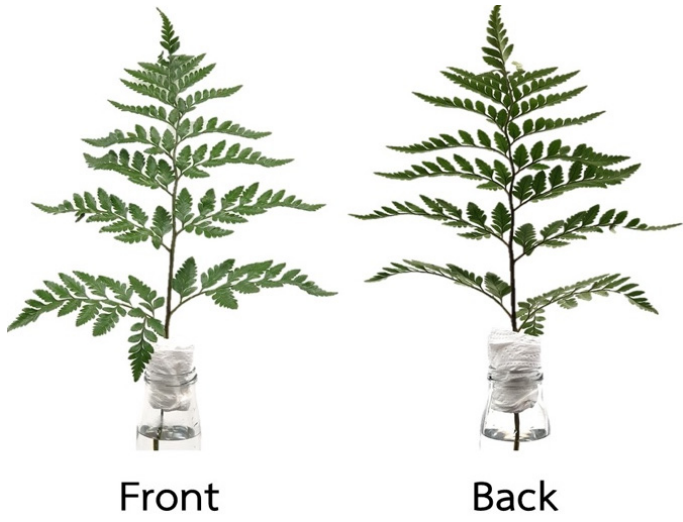
Figure 1. Cut leaves of D. solida used in the